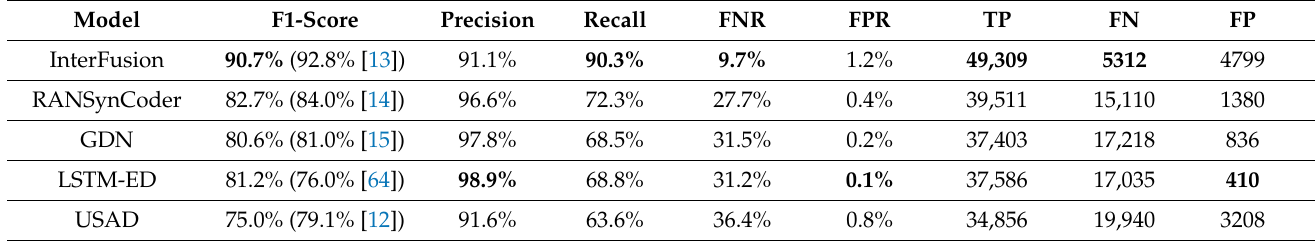
Table 5. Performance of anomaly detection models for the SWaT